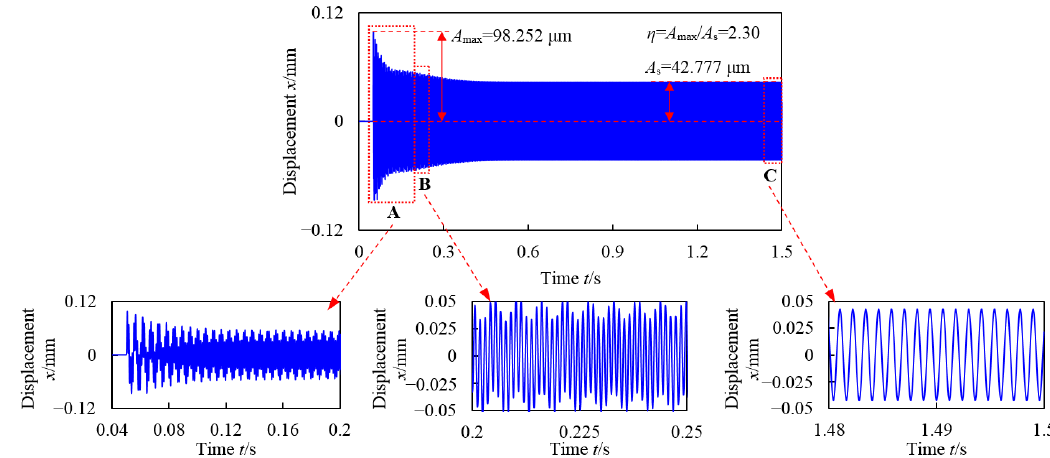
Figure 11. The time-domain response of Node 11 (C.G. position) in the horizontal direction.